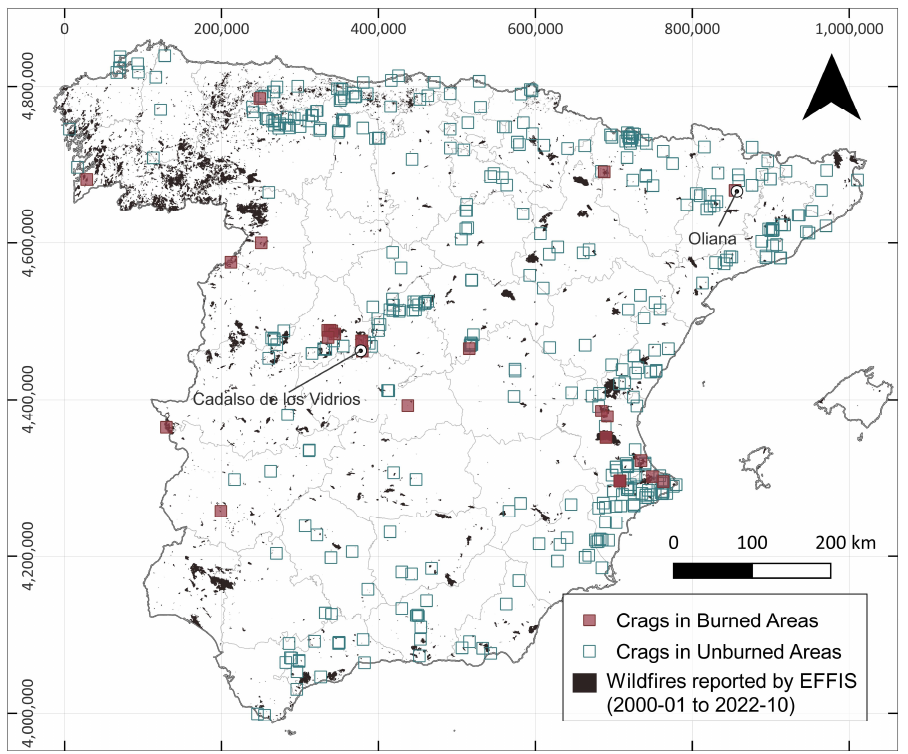
Figure 2. Wildfires reported by the European Forest Fire Information System (EFFIS) during the period 2000–2022 and the climbing areas in Spain. The red circles show the distribution of burned climbing areas in the last two